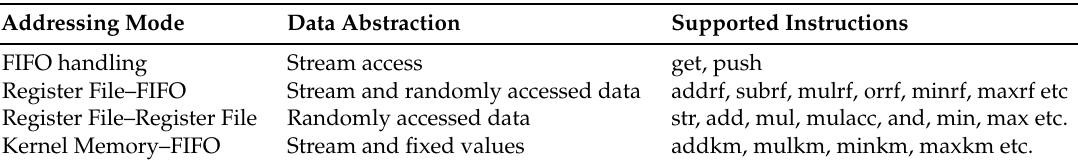
Table 3. IPPro supported addressing modes highlighting the relation to the data processing requirements and the instruction